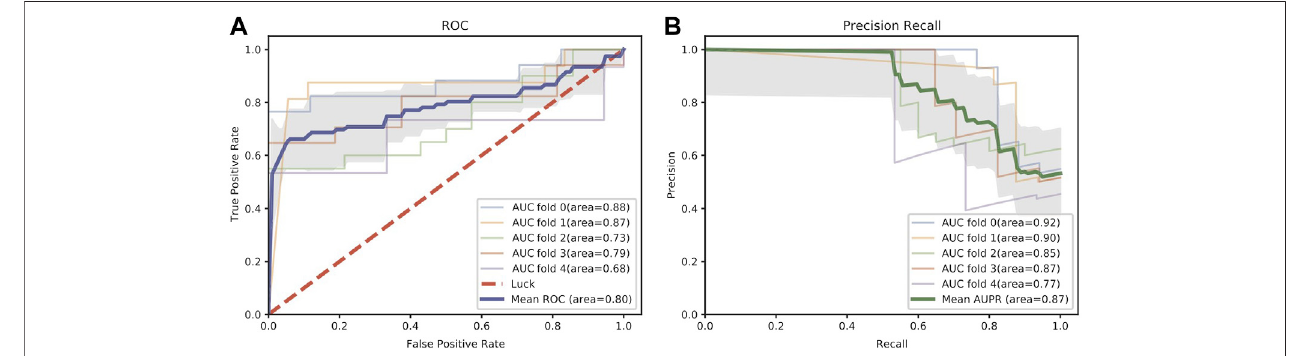
FIGURE 2 | ROC (A) and PR (B) curves in fi ve-fold cross-validation of the miRNA-disease association prediction task. The shaded area means the estimated standard deviation of ROC and PR curves around the mean across fi ve-fold cross-validation.